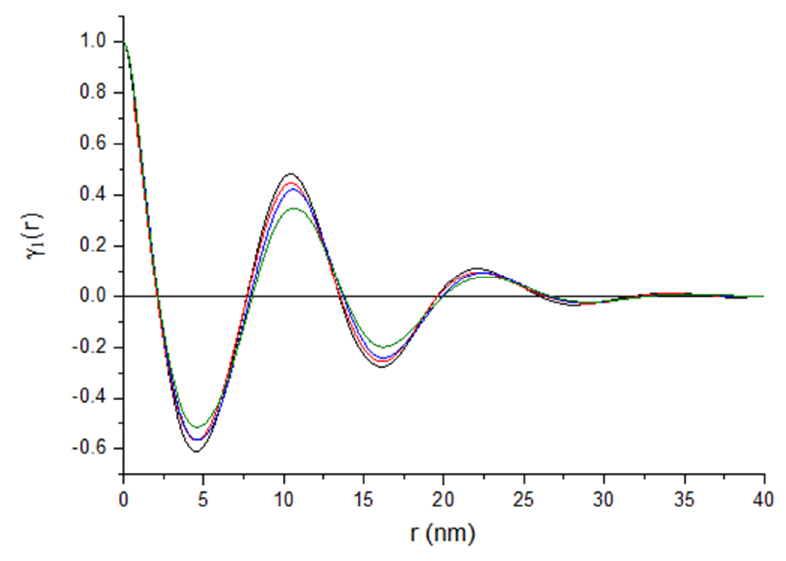
Figure 10. One-dimensional correlation functions for fibers taken at 200 m / min.